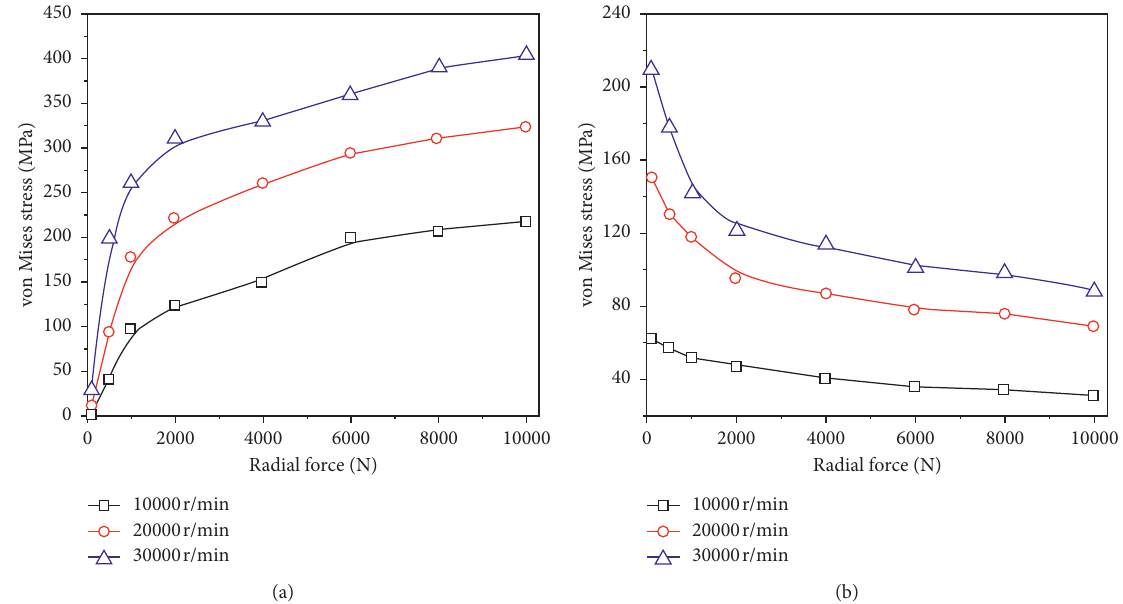
Figure 12: Influence of radial load Fr on cage stress at the stage of start-up and stop. (a) Cage stress at the stage of start-up. (b) Cage stress at the stage of stop.